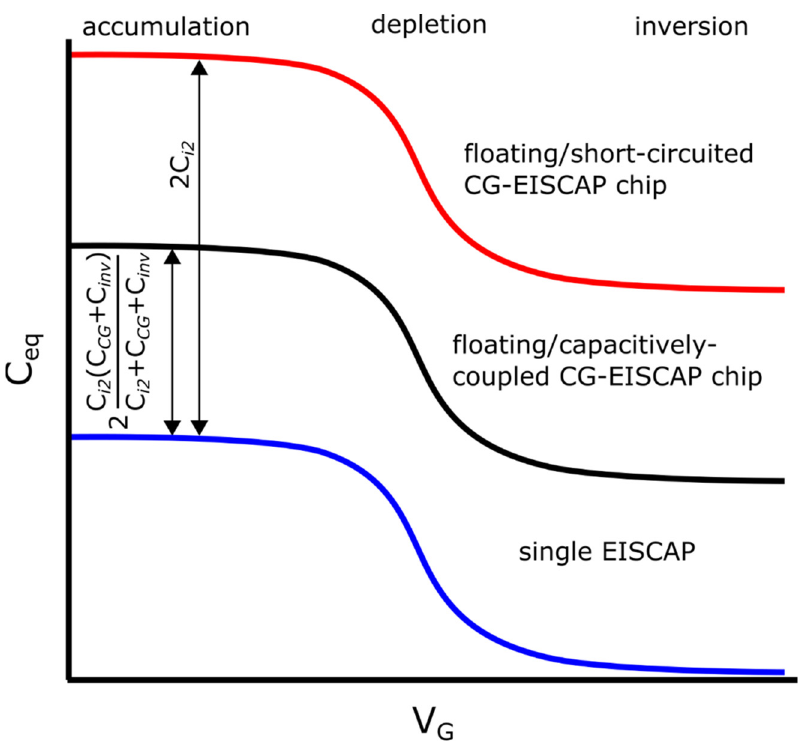
Figure 5. C–V curves of a single EISCAP sensor (blue), a floating/short-circuited (red) and a floating/capacitively-coupled (black) CG-EISCAP chip (schematically).